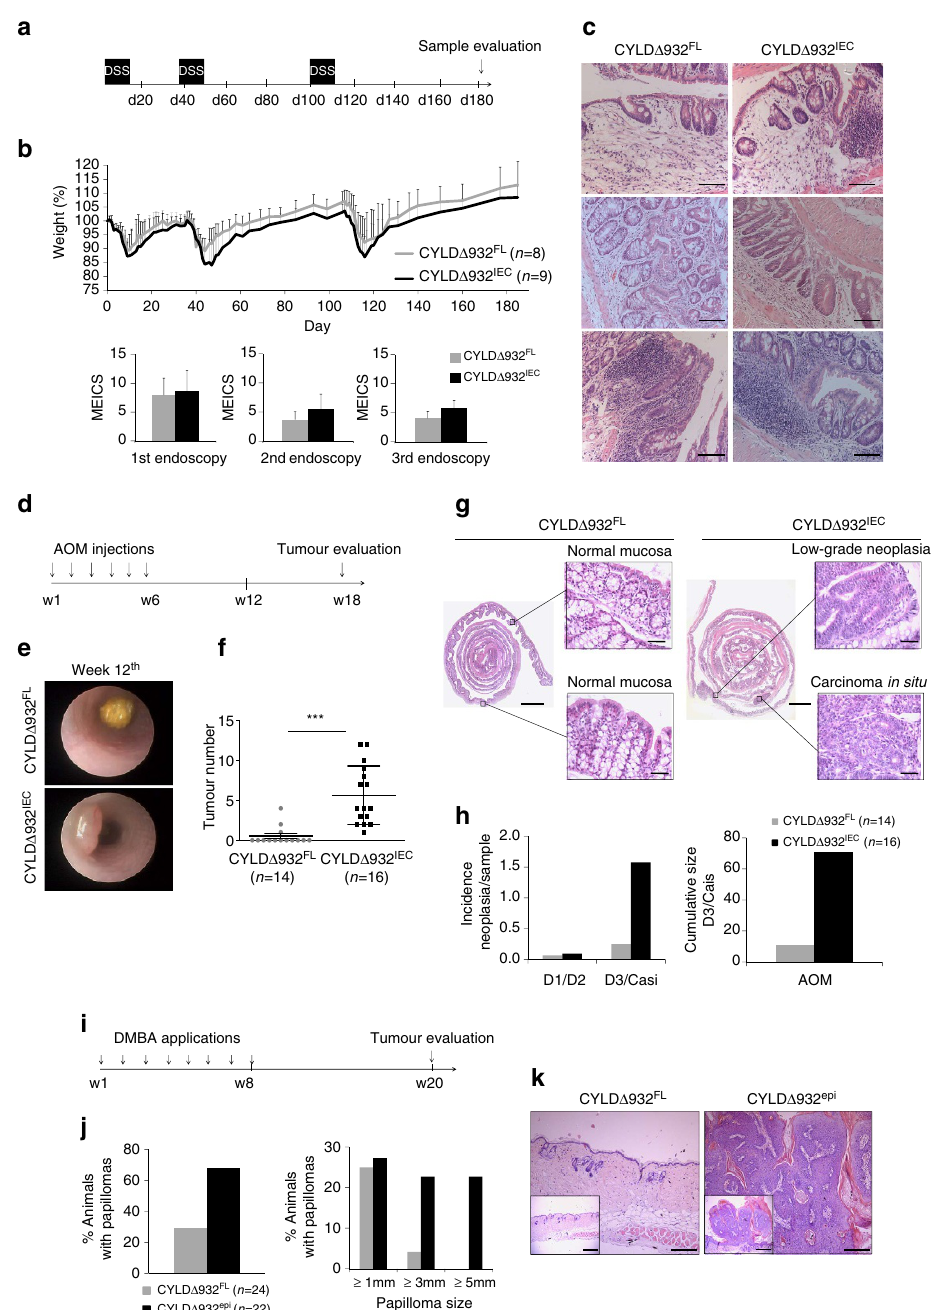
Figure 2 | CYLD suppresses DNA damage-induced tumorigenesis independent of inflammation. ( a ) CYLD D 932 IEC and CYLD D 932 FL male mice were given three 7-day cycles of 2% DSS in the drinking water. ( b ) Graphs showing body weight throughout the treatment and quantification of MEICS after each DSS cycle. ( c ) Representative H&E-stained distal colon sections from DSS-treated mice on day 180. Scale bar, 100 m m. One representative out of two independent experiments is shown. ( d ) CYLD D 932 IEC and CYLD D 932 FL female littermates received weekly injections of 10mgkg (cid:2) 1 AOM for 6 weeks. ( e ) Representative endoscopic images on week 12. ( f ) Graph showing colon tumour numbers on week 18. ( g ) Representative H&E-stained histological images on week 18. Scale bar, 2,500, 50 m m. ( h ) Graphs showing the incidence of low-grade intraepithelial neoplasia (D1/D2) and high-grade intraepithelial neoplasia/carcinoma in situ (D3/Cais), and the cumulative size of high-grade intraepithelial neoplasia/carcinoma in situ D3/(Cais) in the indicated mice exposed to AOM. The evaluated samples comprise specimens from experiments shown in Fig. 2d-h. Pooled data from three independent experiments is shown. ( i ) 25 m g of DMBA was applied on the back of CYLD D 932 FL and CYLD D 932 epi female mice once a week during 8 weeks. ( j ) Graphs showing quantification of papilloma development on week 20. ( k ) Representative H&E-stained histological images of skin from the indicated mice on week 20. Scale bar, 500 and 200 m m. Pooled data from three independent experiments are shown. For all experiments data are shown as mean ± s.d. Statistical significance was determined with Student’s t -test; *** P r